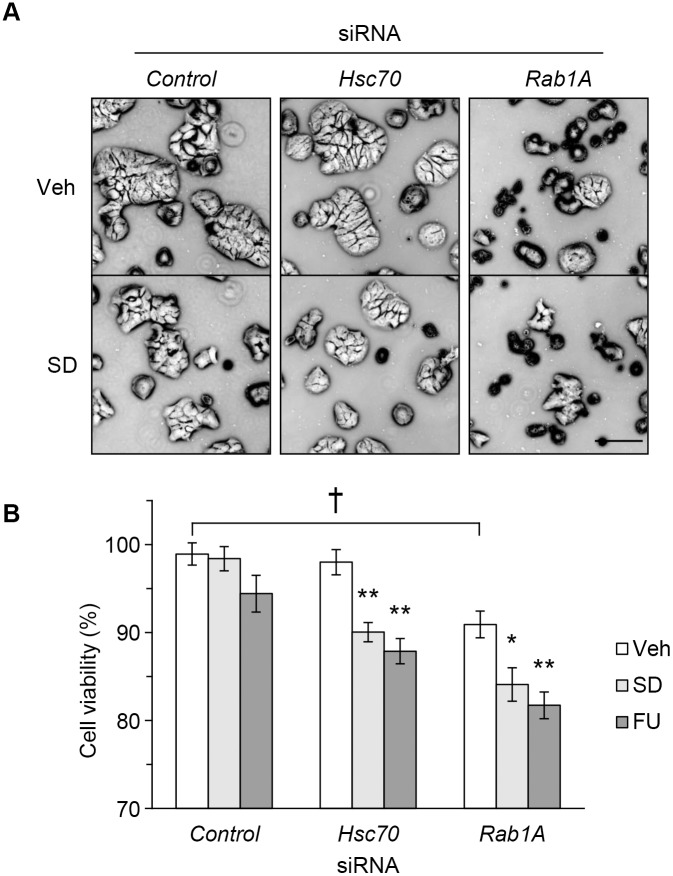
Rab1A knockdown exacerbated stress damage due to serum depletion and 5-FU treatment.HT29 cells transfected with Hsc70, Rab1A, or control siRNA were subjected to serum depletion, 5-FU, or vehicle treatment for 24 h. (A) Effects of suppression of Hsc70 and its interactors on cellular morphology. Representative phase-contrast images of cells. Scale bar, 100 µm. (B) Rab1A knockdown decreased cell viability. Cell viability was determined by MTS assay. Asterisks indicate statistical significance. **, p<0.01, *, p<0.05 vs. vehicle; †, p<0.05 vs. control knockdown by two-way ANOVA followed by Tukey-Kramer post hoc test; values are the means ± S.D. (n = 7). Veh, vehicle. SD, serum depletion. FU, 5-fluorouracil.